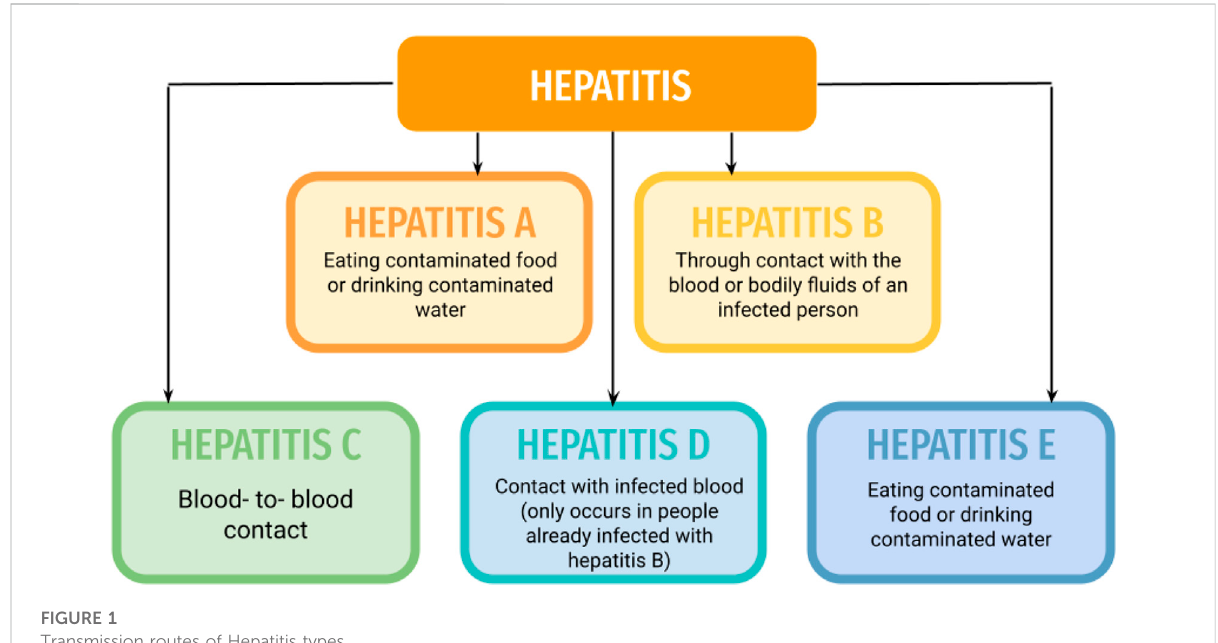
FIGURE 1 Transmission routes of Hepatitis